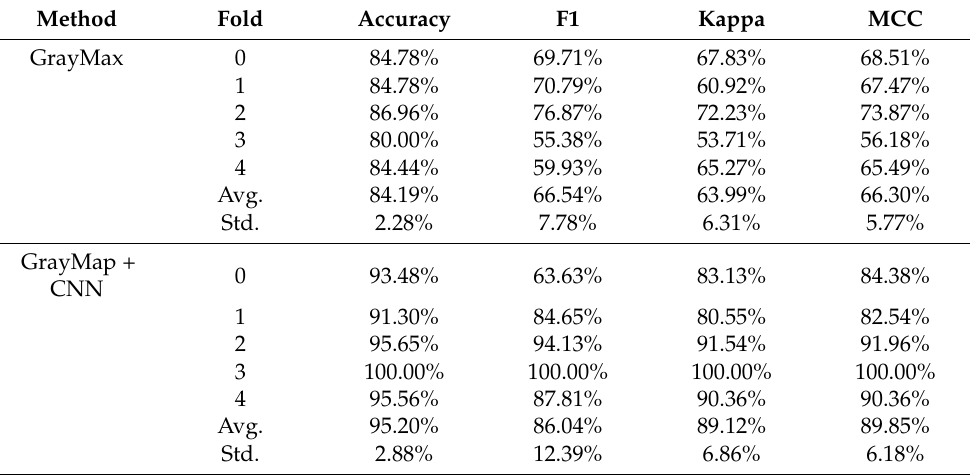
Table 2. Performance comparison of GrayMax and GrayMap + CNN methods by cross-validation classification. Method Fold